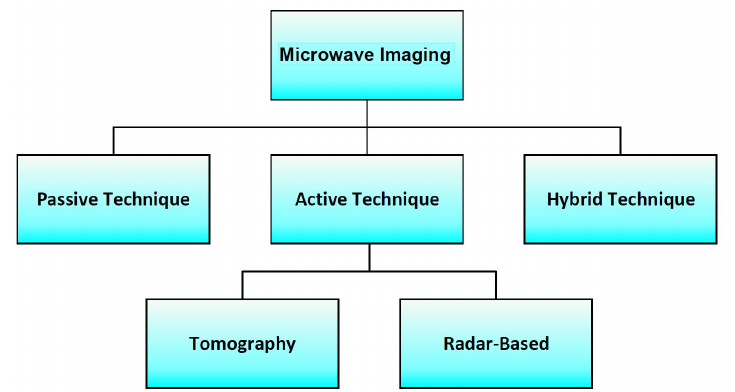
Figure 2. Block diagram showing the different modalities that have been explored for microwave-based breast cancer